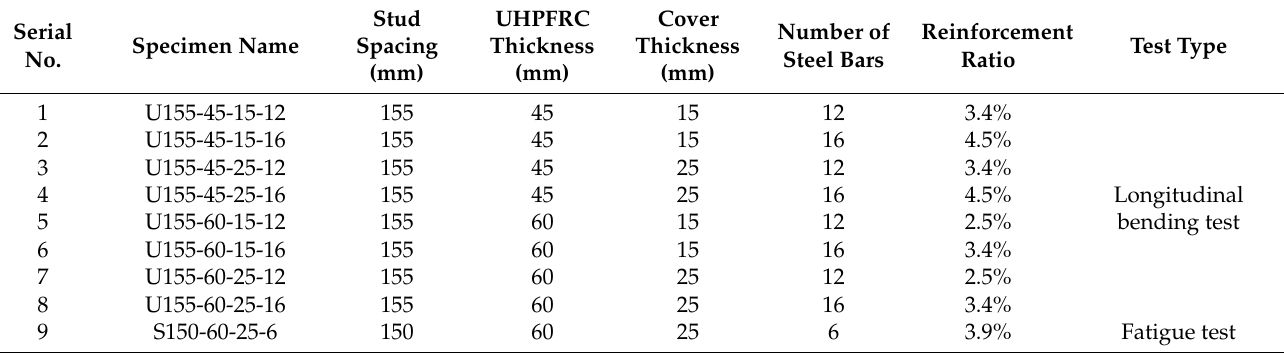
Table 2. Summary of test